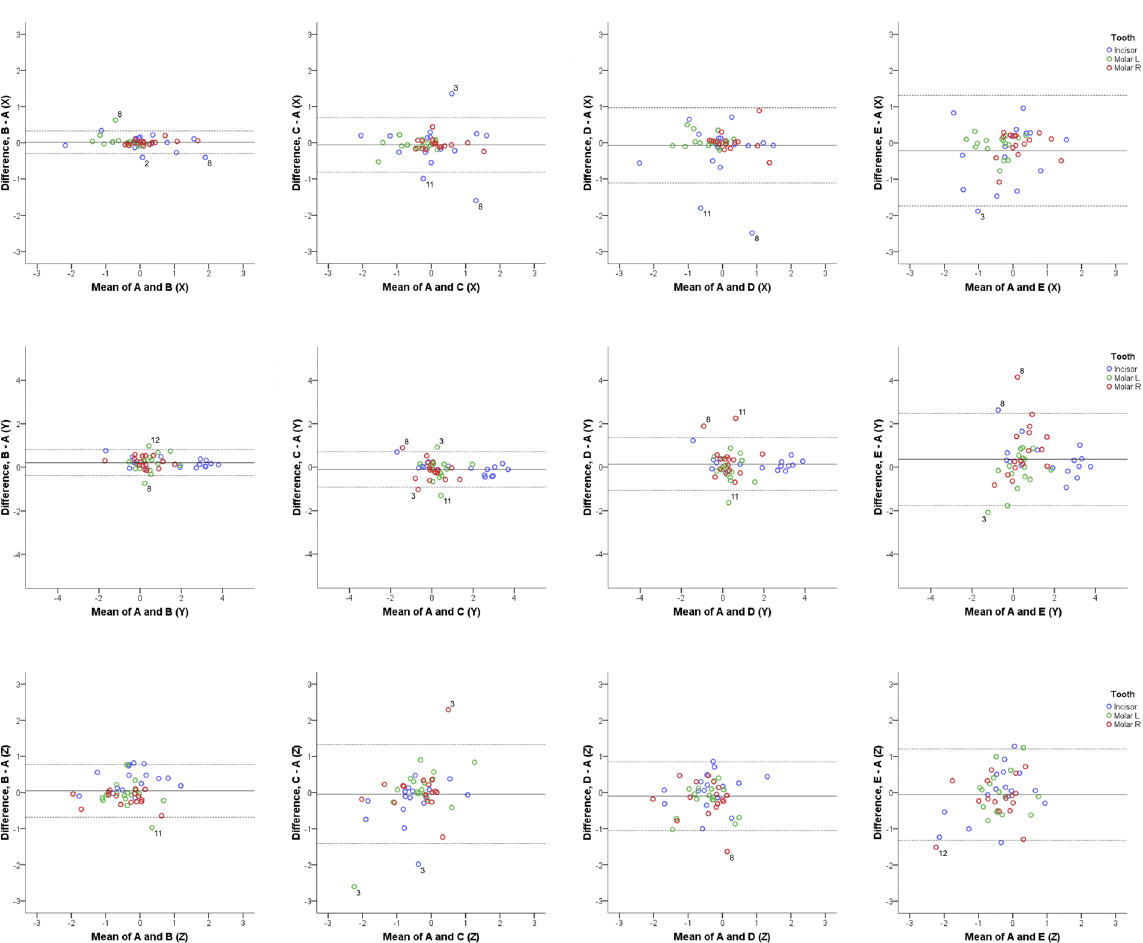
Figure 3. Differences of B, C, D, and E from the gold standard technique (distances). Bland Altman plots of differences of B, C, D and E superimposition techniques from the gold standard superimposition technique regarding the measured tooth movements of the three teeth of interest in the three planes of space (mm). The axes length represents the true range of observed values of structural changes. The continuous horizontal line shows the mean and the dashed lines the 95% confidence intervals. Point labels represent patients with values located outside the 95% confidence intervals of each set of